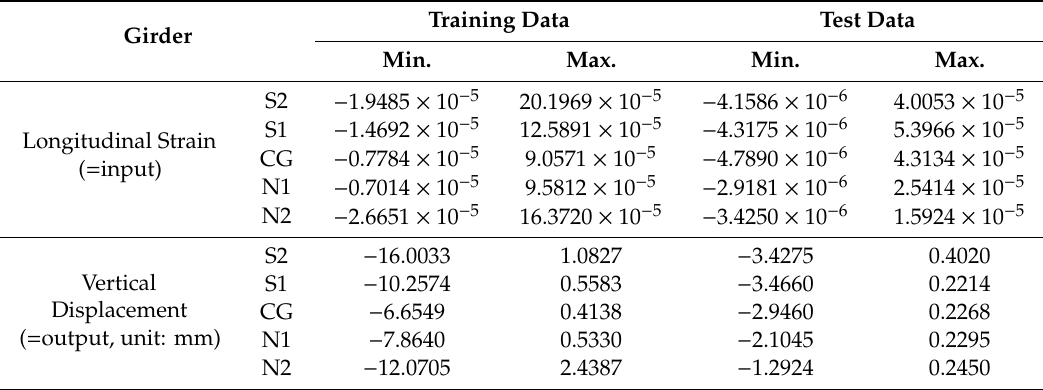
Table 3. Ranges of strain and displacement values.